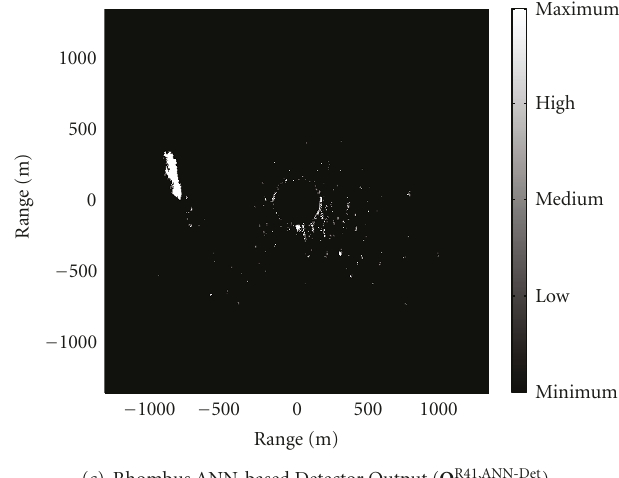
Figure 5: Radar Images Processed by the ANN-based Detection System Using its Best H, V, and R Integration Modes.